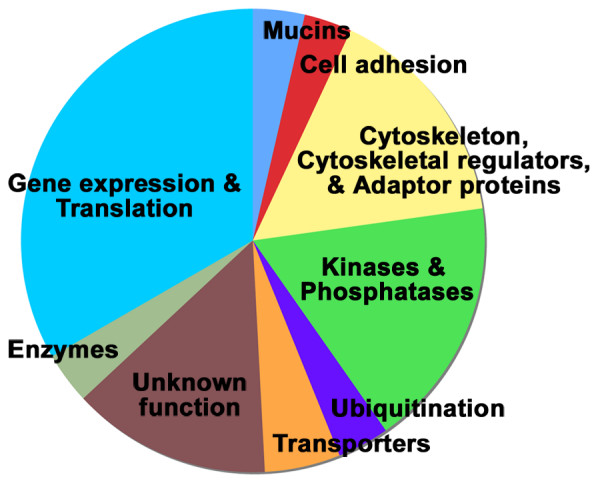
Pie chart showing the different types of proteins encoded by the insertion loci identified in the screen. The size of the pie wedge represents the proportion of genes of each type identified. Functional categories were based on previously published studies of the Drosophila gene and/or sequence similarity to functionally annotated mouse genes. Table 1 contains a complete list of the genes represented in this chart.